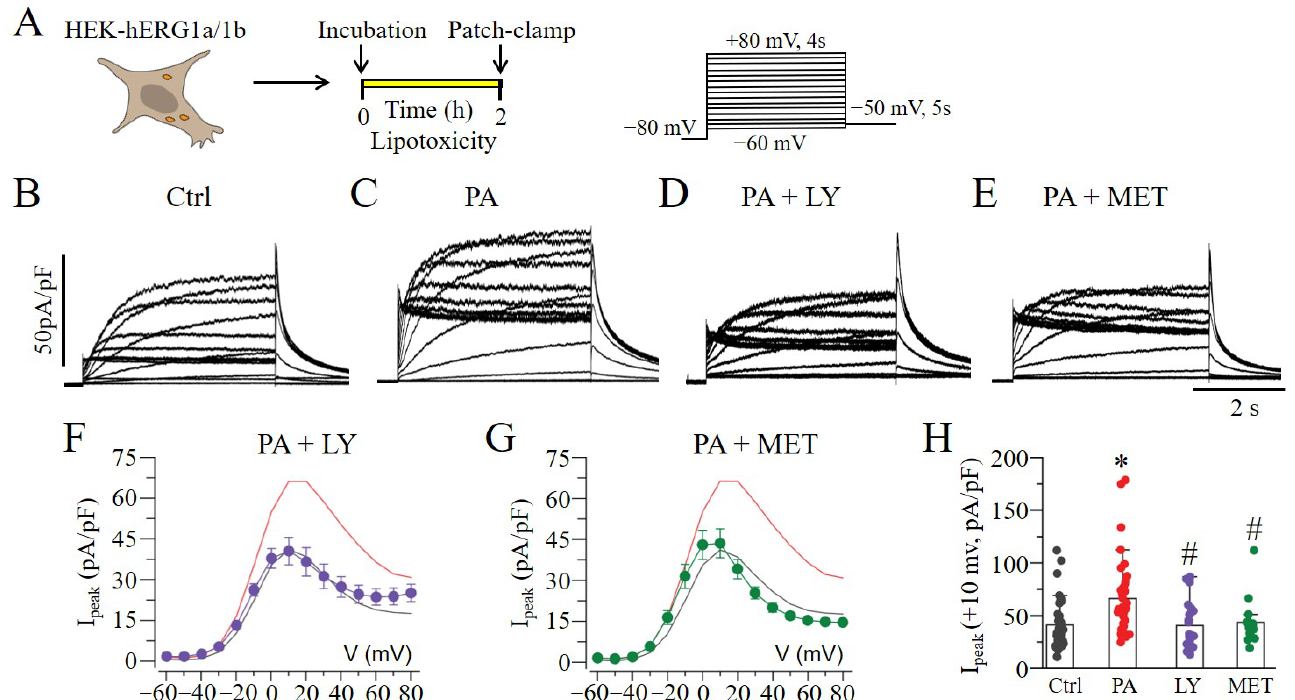
Figure 2. The effect of mTOR signaling on hERG1a/1b currents. ( A ) Experimental protocol: Macroscopic hERG1a/1b currents measured in HEK293 cells under control conditions and 2 h after lipotoxicity exposure, using the illustrated voltage protocol. ( B – E ) Exemplar traces of currents measured in control and lipotoxic cells (PA) in the absence and presence of the PI3K–Akt inhibitor LY and AMPK activator MET. ( F – H ), Pooled I peak – V curves, and averaged peak current at +10 mV for 1a/1b measured in lipotoxic cells in the presence of LY ( , and purple line ) and MET ( , and green line ). The I peak – V curves for hERG1a/1b currents measured in control cells ( black line ) and in cells pre-treated with lipotoxicity ( red line ) are shown for comparison. (* statistical significance at p < 0.05; # statistical non-significance at p > 0.05).